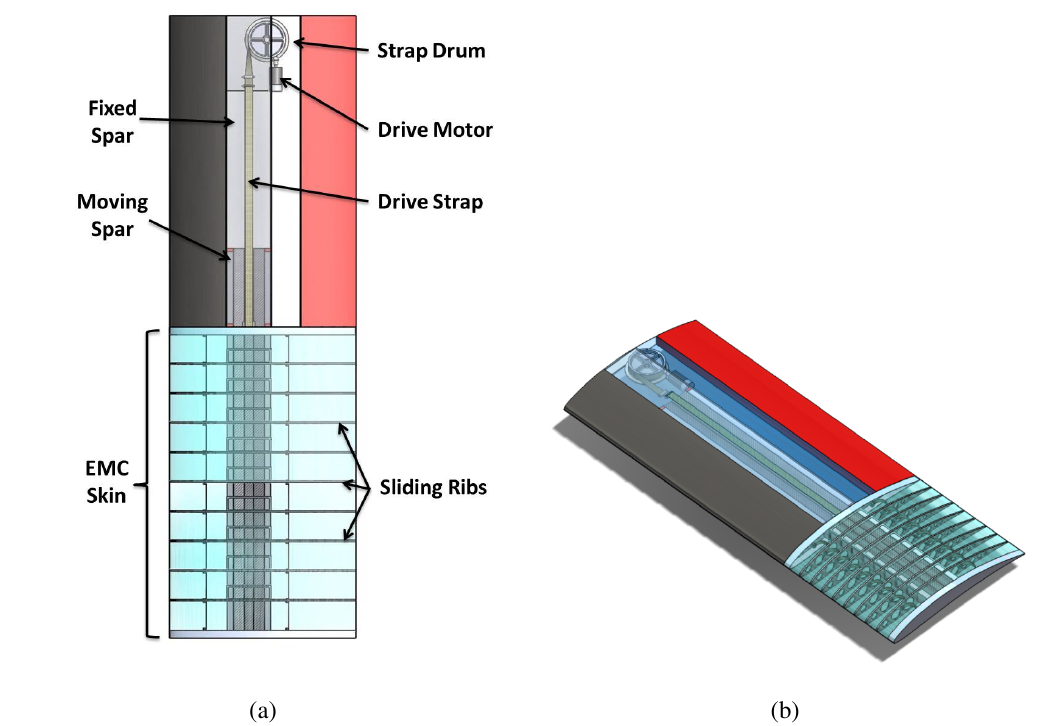
Figure 1. Schematic of the adaptive aspect ratio (AdAR) span-morphing concept applied to a straight, unswept, untapered wing. ( a ) Top view of the AdAR wing concept, span extended; ( b ) isometric view of the AdAR wing concept, span